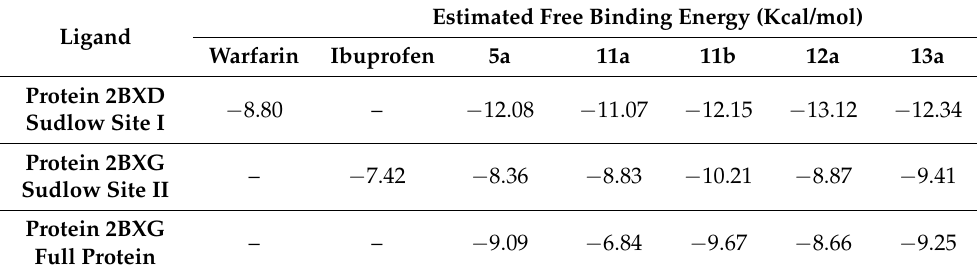
Table 5. Estimated free binding energy of warfarin, ibuprofen, and squaraine dyes 5a , 11a , b , 12a , and 13a in Sudlow sites I and II and full human serum albumin